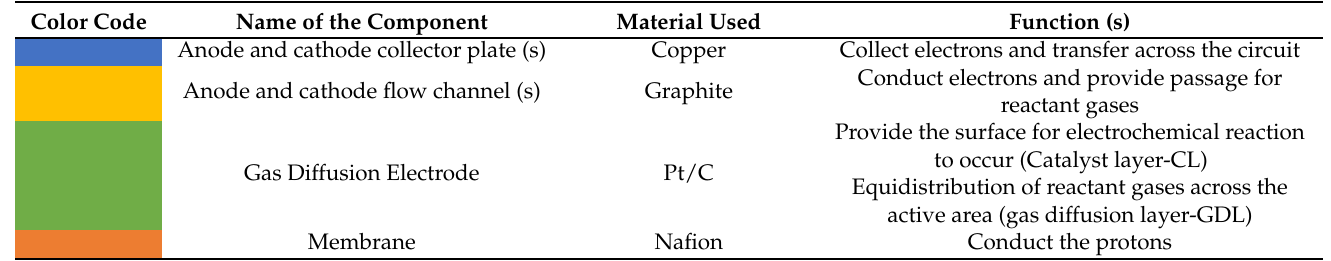
Table 4. PEM Fuel cell components, material usage, and specific functions (with reference to the color code in Figure